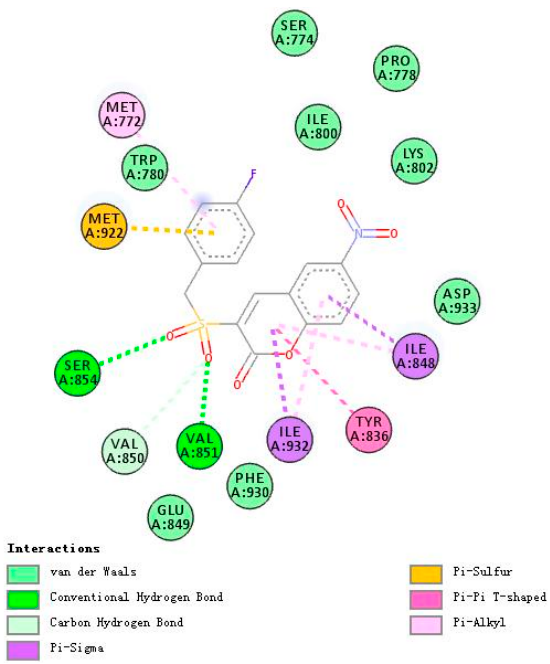
Molecules 2019 , 24 , x FOR PEER REVIEW Figure 5. A 2D model of the interaction between compound 5h with the active site of PI3K α .